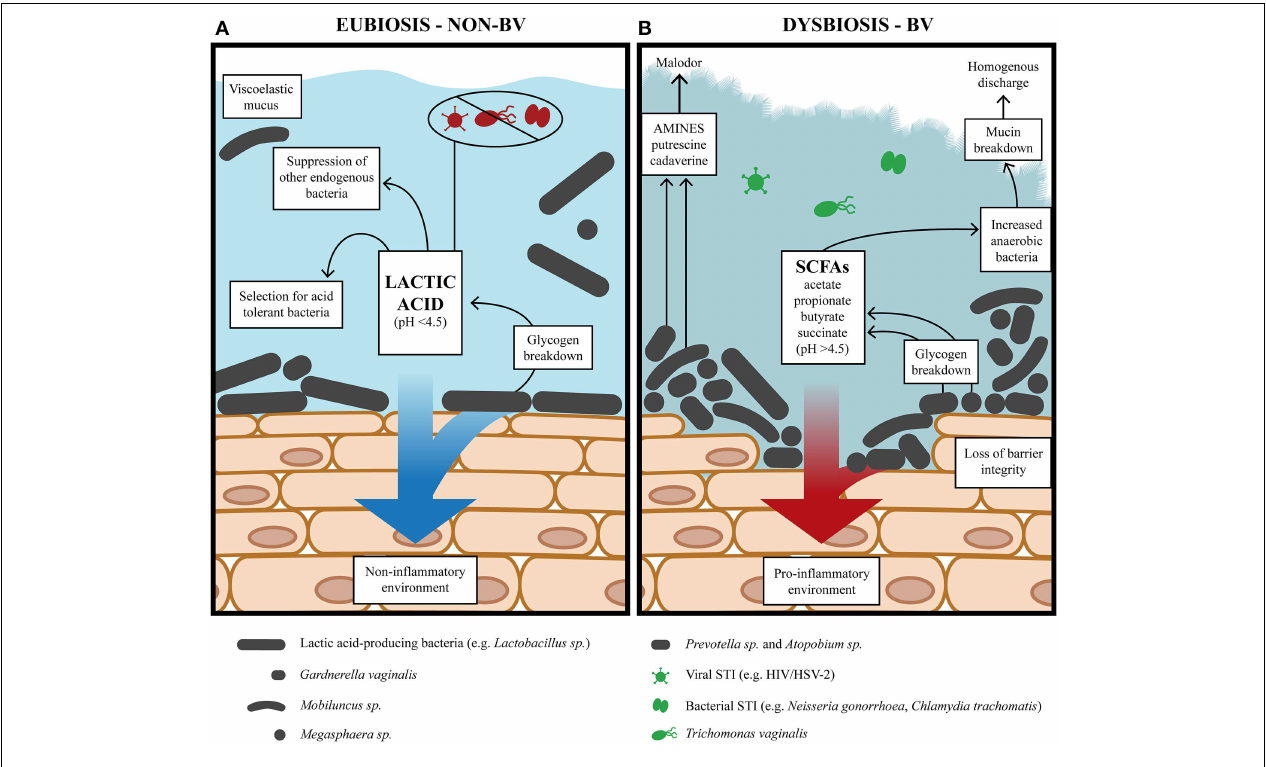
potential conducive to the growth of diverse anaerobic bacteria and higher bacterial load. The concentration of mixed SCFAs and amines also increase and is accompanied by loss of vaginal acidity pH > 4.5. The diverse anaerobic bacteria generate virulence factors which compromise epithelial barrier integrity, degrade mucin and generate a pro-inflammatory